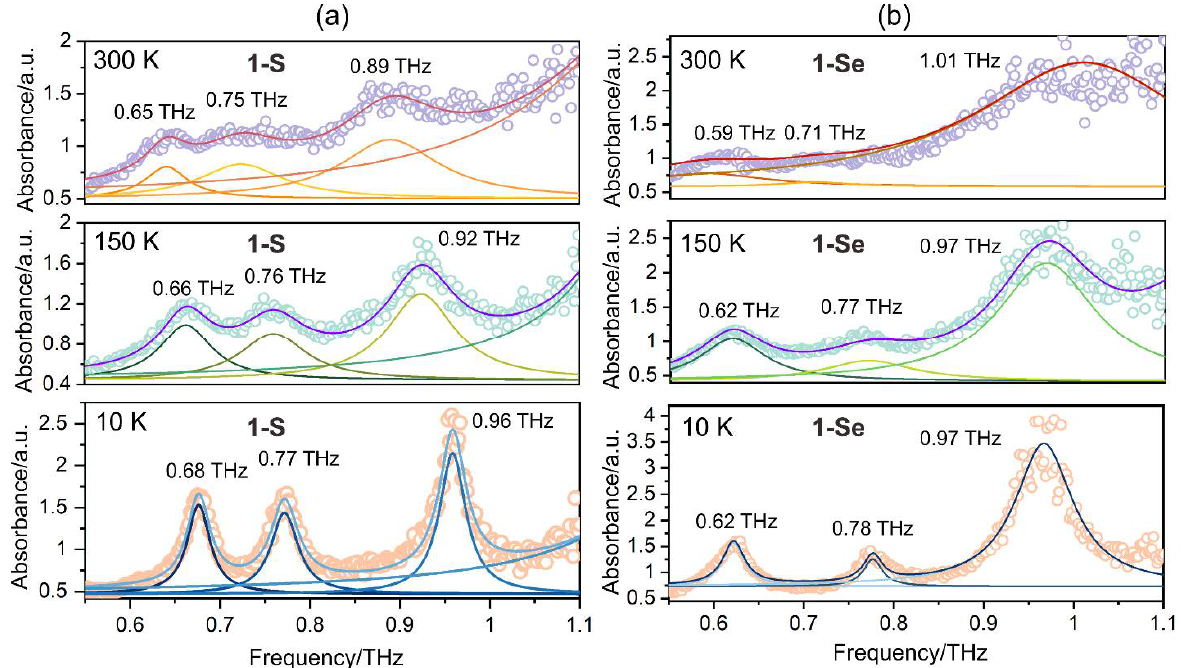
Figure 4. ( a , b ) THz-TDS spectra of 1-S and 1-Se measured at 300, 150, and 10 K. Each spectrum is deconvoluted with the Lorentzian function. The circles indicate experimental data, and the solid line shows fitting functions. Simulated cumulative plots and Lorentzian components for 3 different phonons at 300, 150, and 10 K are represented as red/orange, violet/green, and blue/dark blue lines.